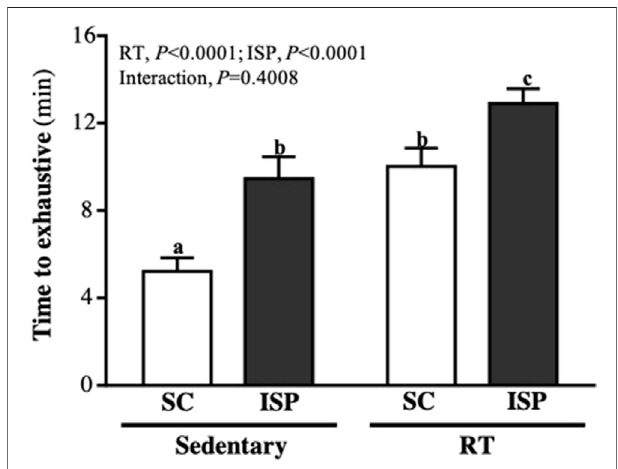
FIGURE 4 | Effect of ISP supplementation and RT of aging mice on endurance exercise performance. Data are expressed as mean ± SD for n = 8 mice per group. Different superscript letters (a, b, and c) indicate signi fi cant difference at p < 0.05.